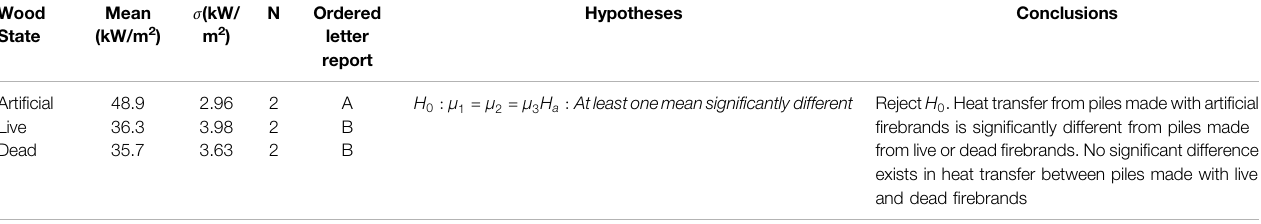
TABLE 10 | Summary of the statistical analysis of the effect of wood state on the heat fl ux from fi rebrand piles. Wood State